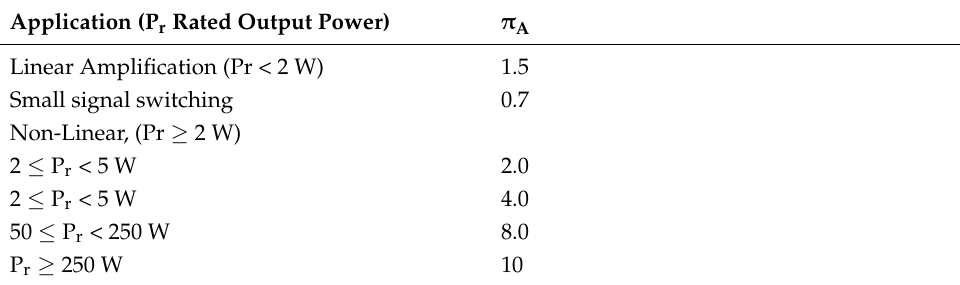
Table 3. Factors of application for different power ratings